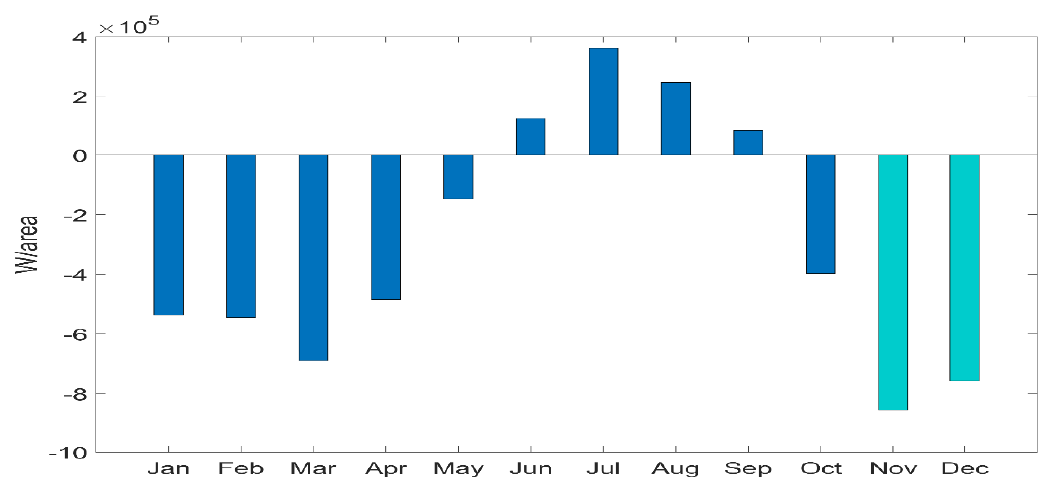
Figure 5. Climatology of monthly integrated heat fluxes for the center of RG from 2001 to 2017. Main heat losses generally occur in November and December (turquoise bars) and initiate the preconditioning phase. Subsequent heat losses in January, February, and March induce dense water formation.